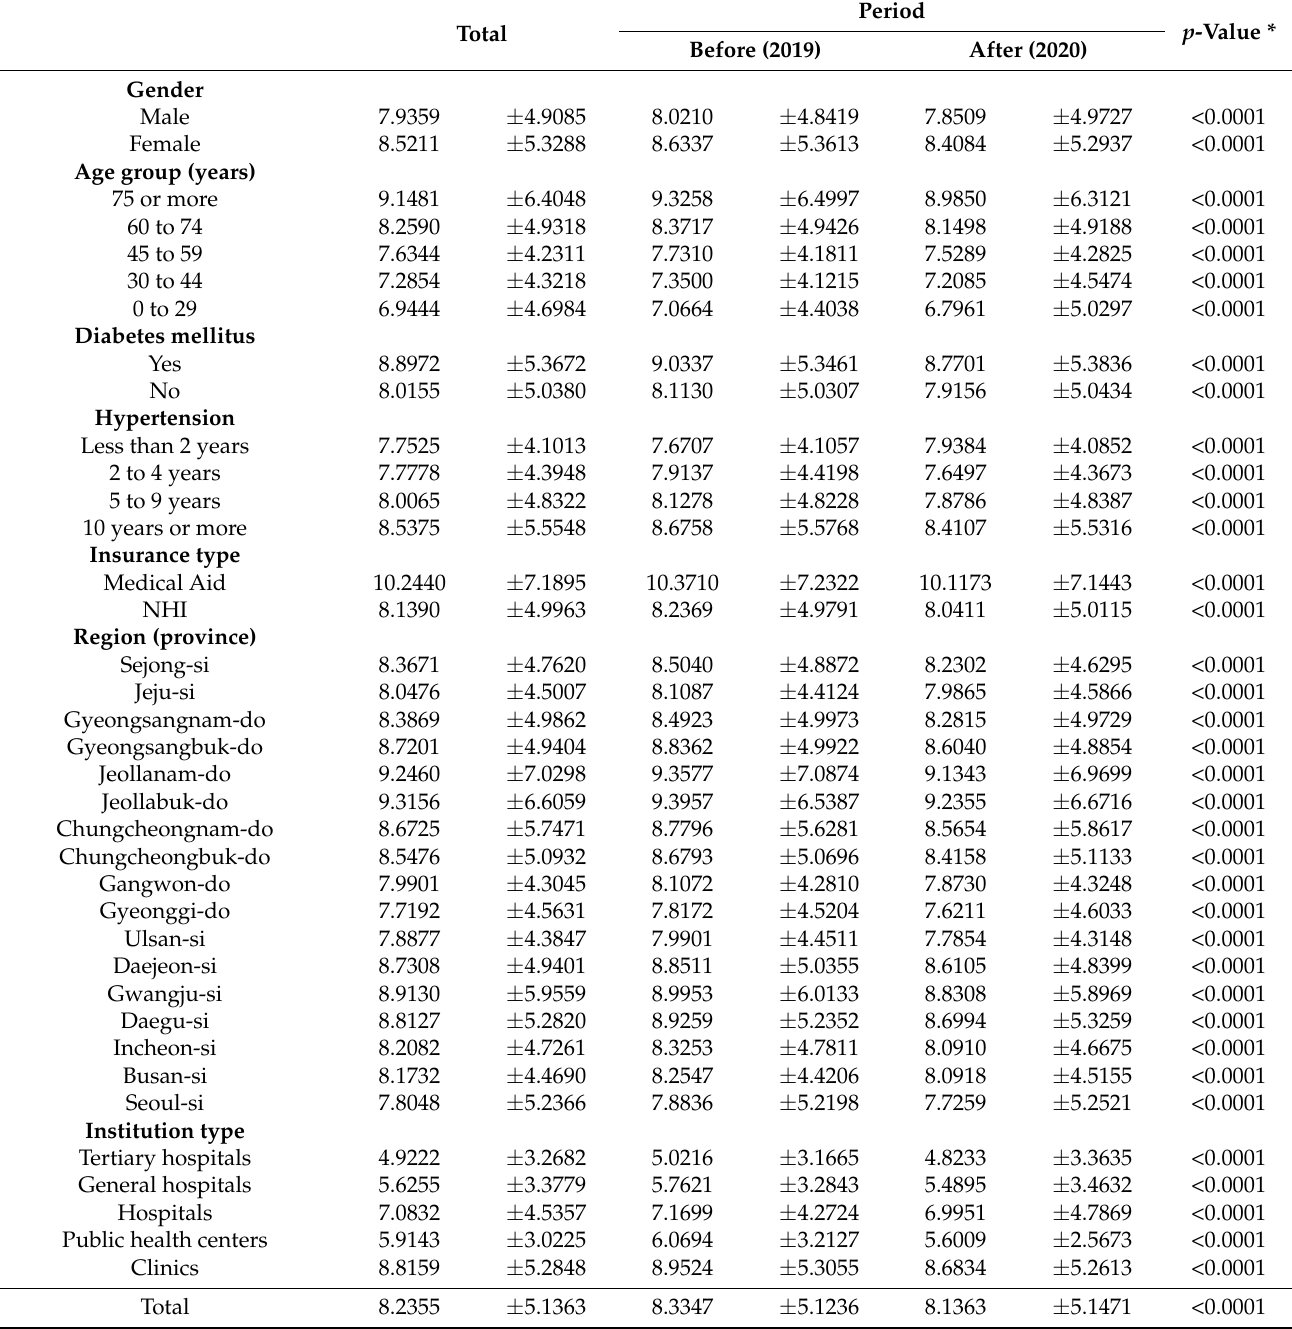
Table 3. Number of outpatient clinic visits per patient (mean ± standard